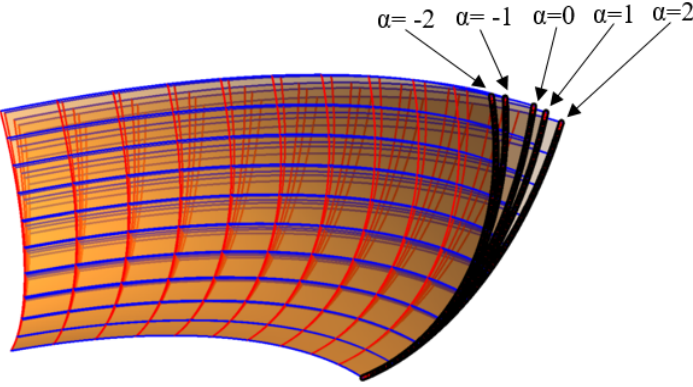
Figure 1. Curvature lines on LA surfaces of revolution with various types of LAC.